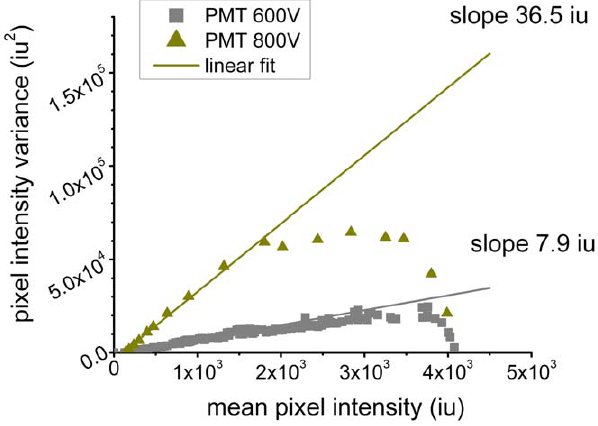
Figure 1. Characterization of the shot noise profiles for PMT detector. Plot of the variance as a function of the mean intensity for uniform illumination acquired with CLSM. Only the initial part of the data was taken into account for linear